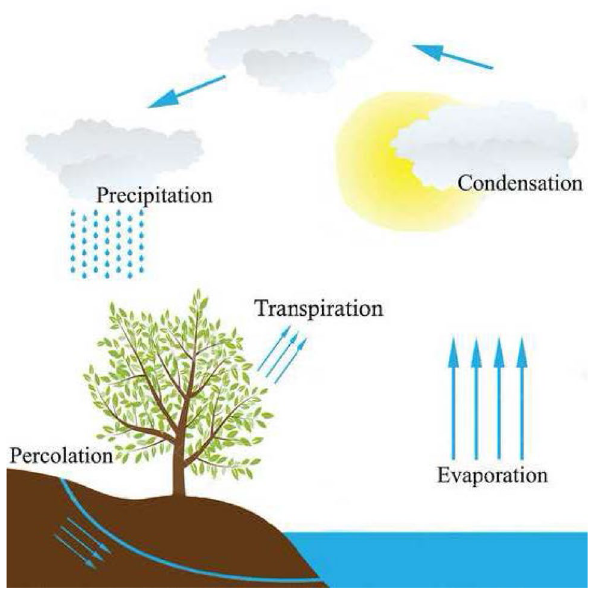
Fig. 1 Schematic diagram of water cycle in the nature (Sadollah et